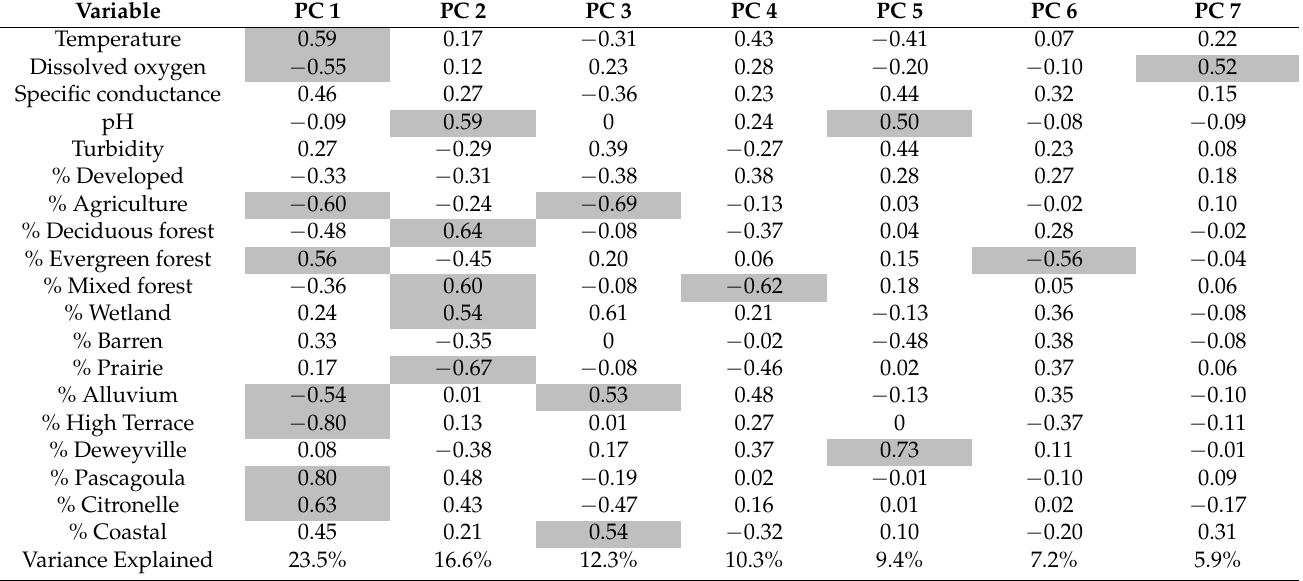
Table 5. Standardized scoring coefficients between variables with principal components (PCs). Shaded numbers were considered informative in interpretation of each